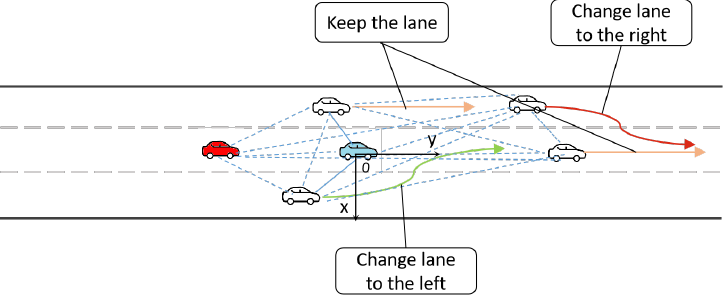
Figure 3. If the red CAV wishes to predict the behavior and trajectory of the blue vehicle, it must consider the interrelationships of all vehicles with the blue vehicles, and the lane-changing behaviors of individual vehicles. A coordinate system for trajectory prediction, where the y -axis points to the direction of movement of the highway, and the x -axis is the direction perpendicular to